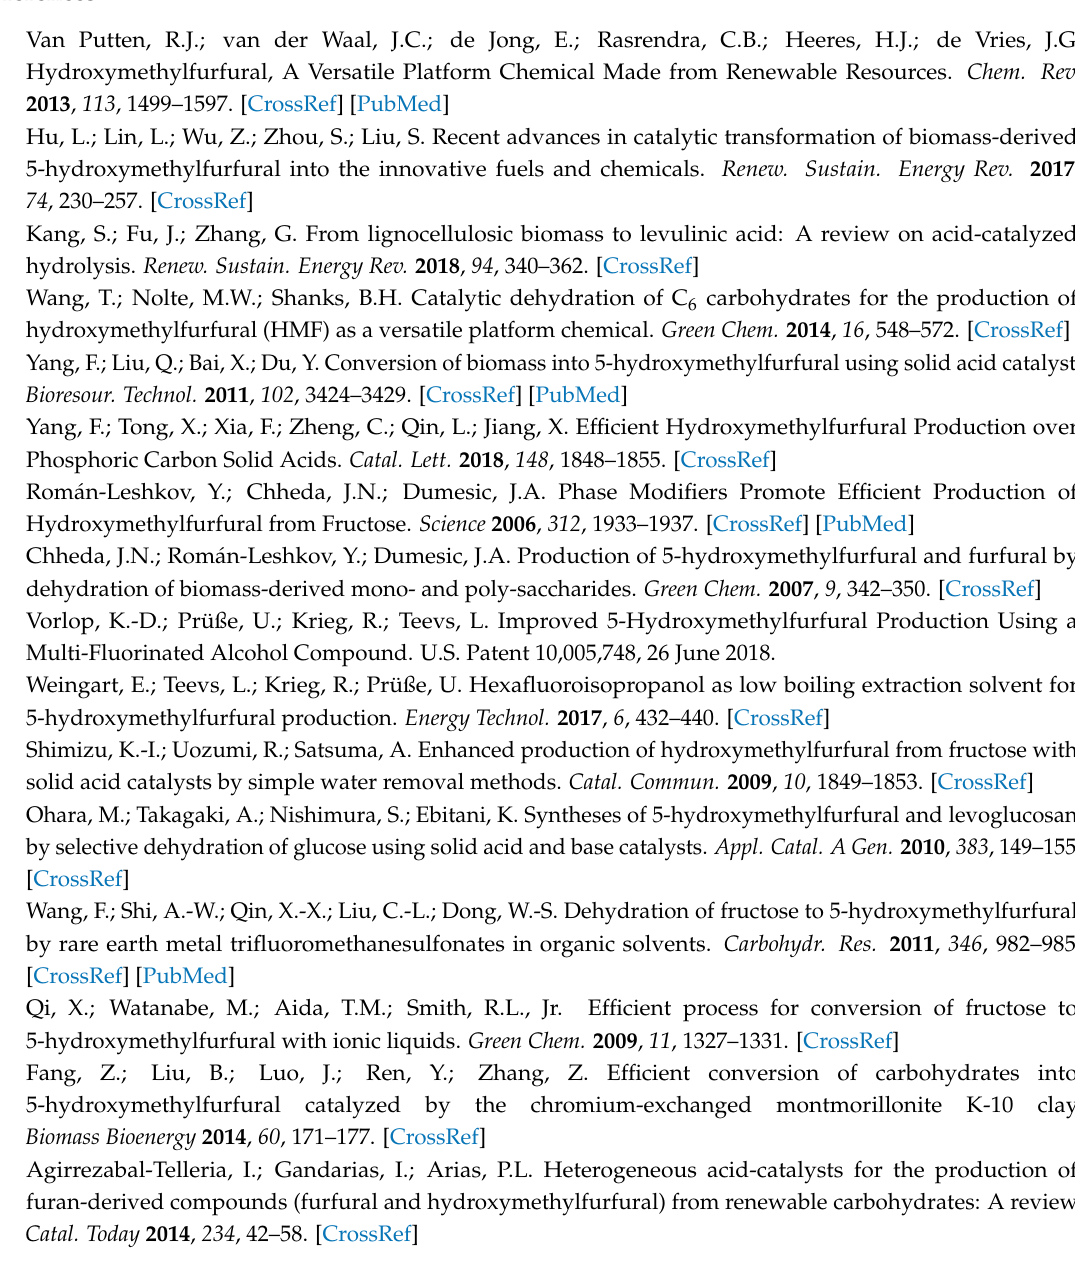
Supplementary Materials: The supplementary materials are available online. Table S1. Properties of applied dry cationic ion-exchange resins. All data were provided by the manufacturer. Table S2. Chemical and physical characteristics as well as safety parameters of 1,1,1,6,6,6-hexafluoroisopropanol